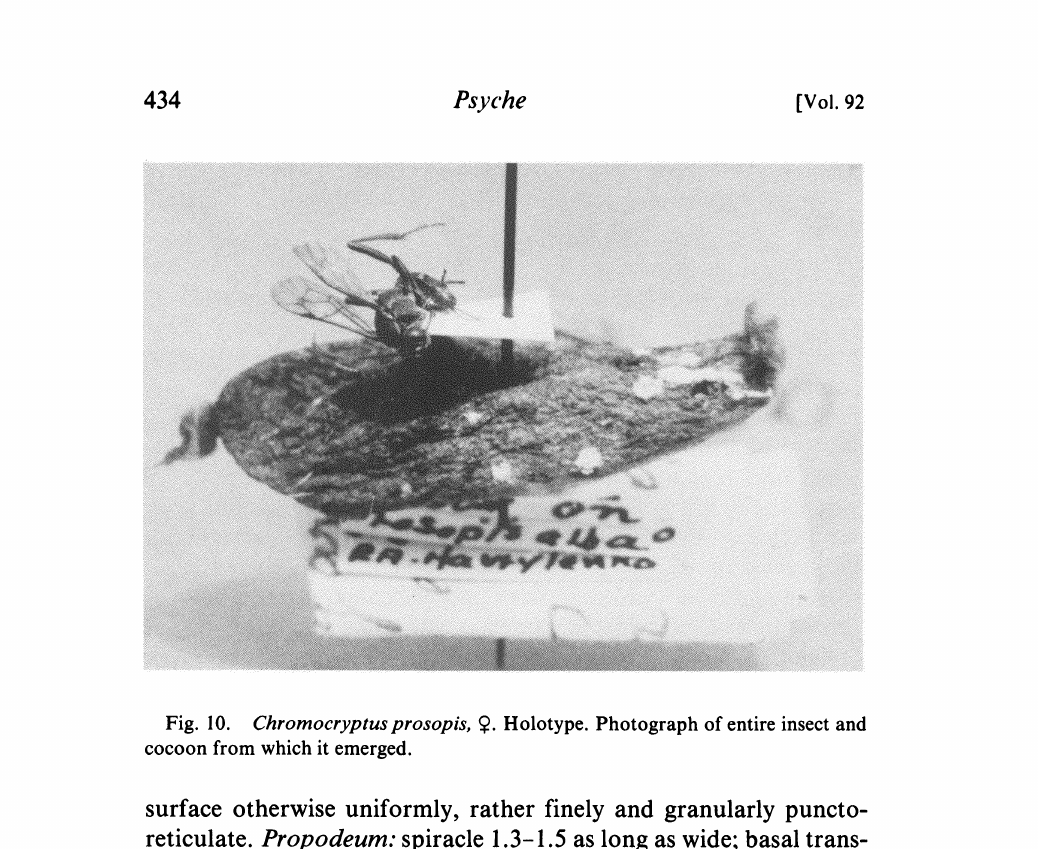
Fig. 10. Chromocryptus prosopis, cocoon from which it